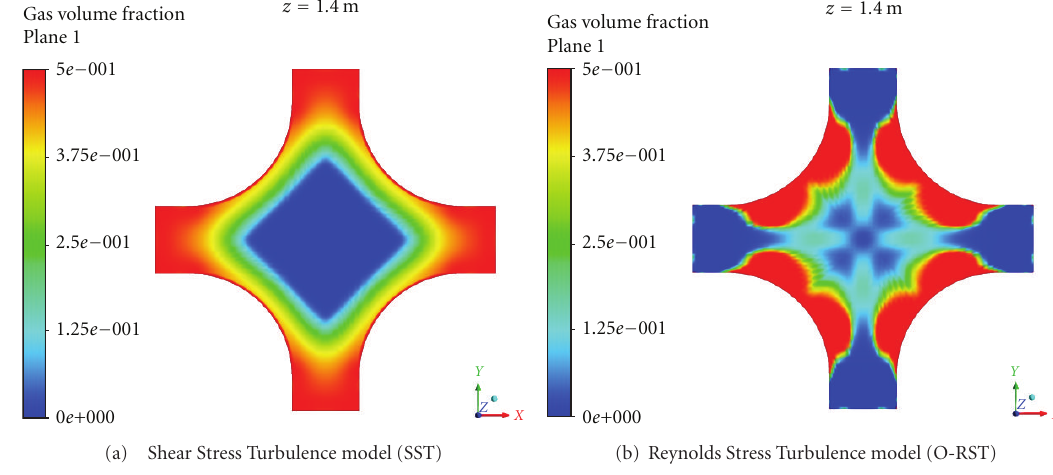
Figure 9: Cross sectionally averaged gas fraction at an axial distance of 1.4 m for run 1.2422.